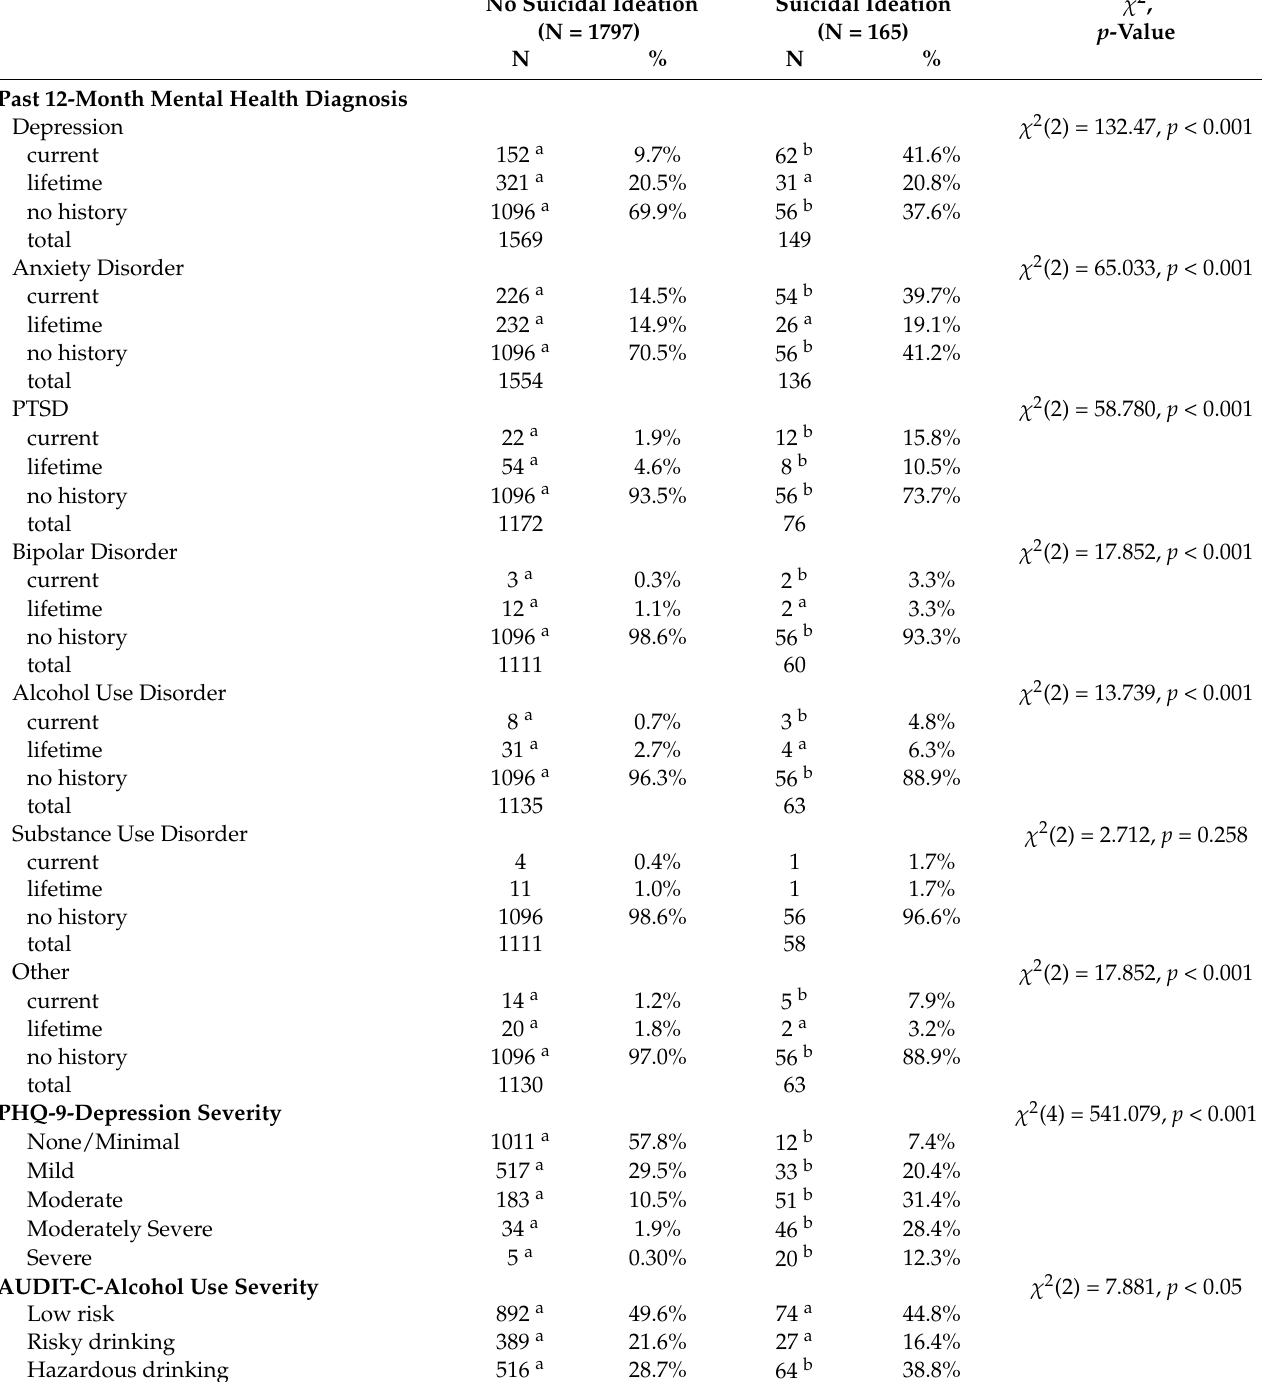
Table 3. The prevalence of mental health diagnoses, severity of depression, alcohol use, substance use, and loneliness in the study sample according to endorsement of PHQ-9 suicidal ideation (N =